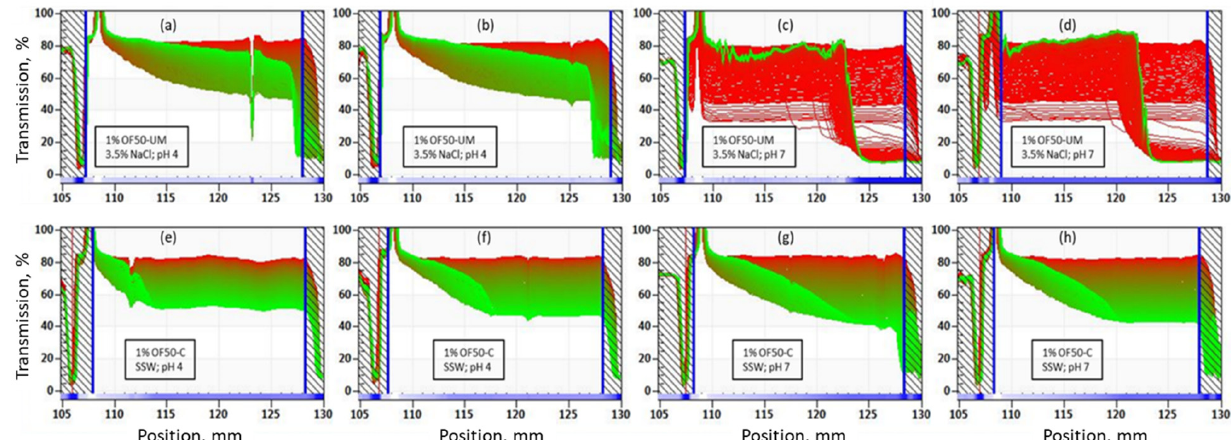
Figure 7. Accelerated stability analysis at 60 °C for 1 wt.% ( a , b ) OF50-UM in 3.5% NaCl brine at pH 4, ( c , d ) OF50-UM in 3.5% NaCl brine at pH 7, ( e , f ) OF50-C1 in SSW at pH 4, and ( g , h ) OF50-C1 in SSW at pH 7. The simulated stability duration was 6 months and runtime of experiment was 31 h.